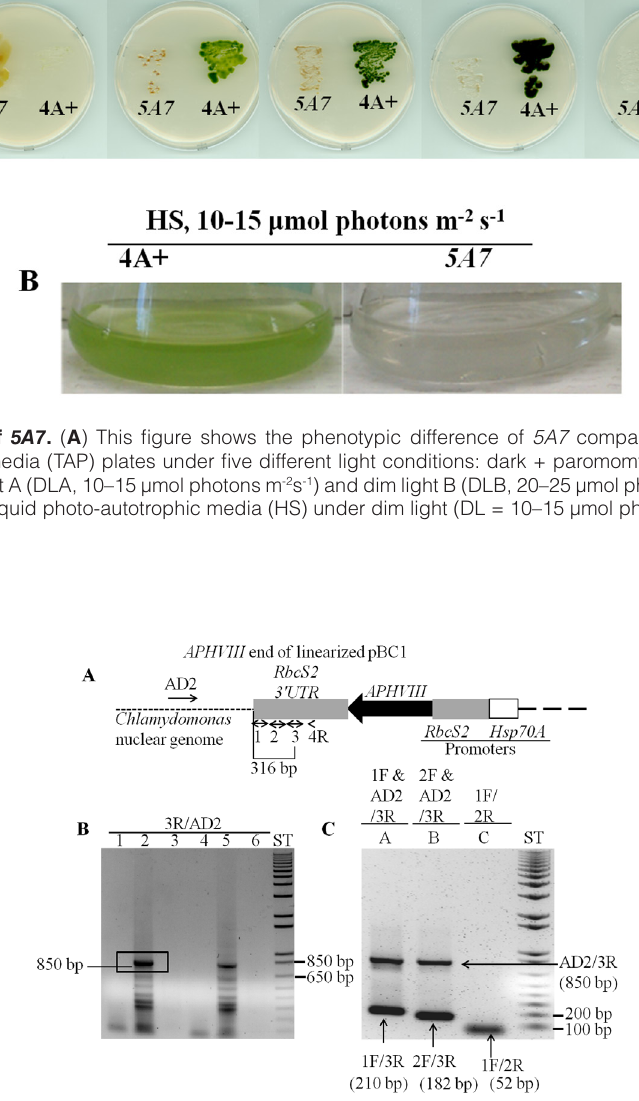
Figure 3. Locating the APHVIII flanking genomic sequence in 5A7 . ( A ) A diagram showing a truncated pBC1 illustrating the APHVIII end of the linearized pBC1 vector. Primers used for PCR are shown by numbered black arrows. Thermal Asymmetric InterLaced 1 (TAIL1) PCR was performed using primer 4R and AD2. ( B ) TAIL2 PCR was performed using primer 3R and AD2. Lanes 1 and 4 are zero DNA lanes; in lane 2, a 10-fold diluted TAIL1 PCR product was used for TAIL2 PCR; in lane 5, a 25-fold diluted TAIL1 PCR product was used for TAIL2 PCR; lanes 3 and 6 are blank lanes. The 850 bp product used for DNA sequencing is highlighted. ( C ) Gel purified DNA product (850 bp) from the TAIL2 PCR was used to verify if the product was specific to the APHVIII gene. F and R stand for forward and reverse primers, respectively. AD2 is a non-degenerate primer. PCR primer names are labeled on the top of the gel. In lanes A and B, where triple primers were used for PCR, PCR products are labeled by the corresponding primer combinations that gave rise to the specific product. PCR product sizes are shown beside the primer combinations. All primer sequences are shown in Table 1. ST stands for 1 kb plus ladder (Invitrogen, Carlsbad, CA). DNA samples were run on a 1% agarose